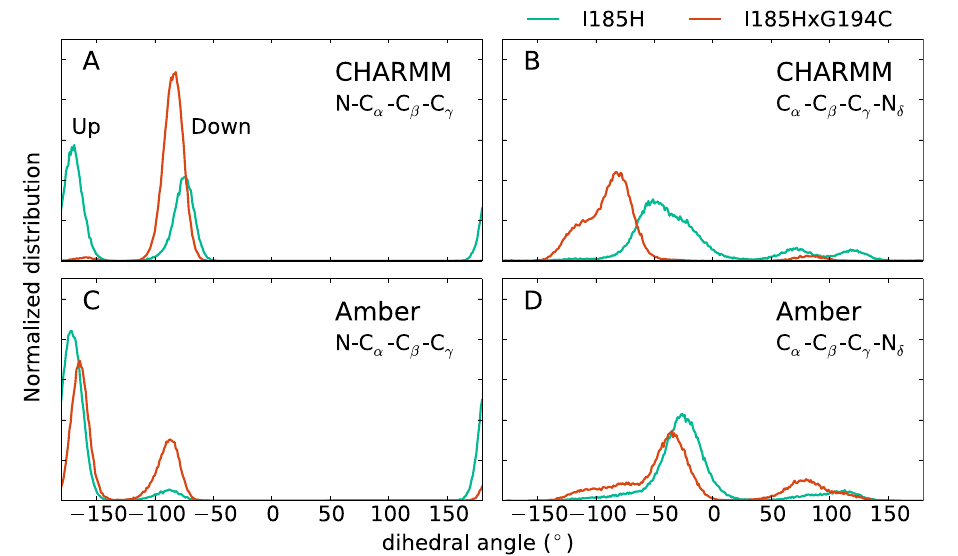
Figure 4. Distributions of two H185 dihedral angles. The N-C α -C β -C γ dihedral ( A , C ) corresponds to moving the H185 aromatic ring further out of (up) or into (down) of the pore, while C α -C β -C γ -N δ ( B , D ) represents a rotation of the aromatic ring. The distributions are different for the single mutant (turquoise) and double mutant (red), indicating the effect of the G194C mutation. Each histogram is based on one 1 μ s long trajectory. See Supplementary Fig. S2 for the corresponding